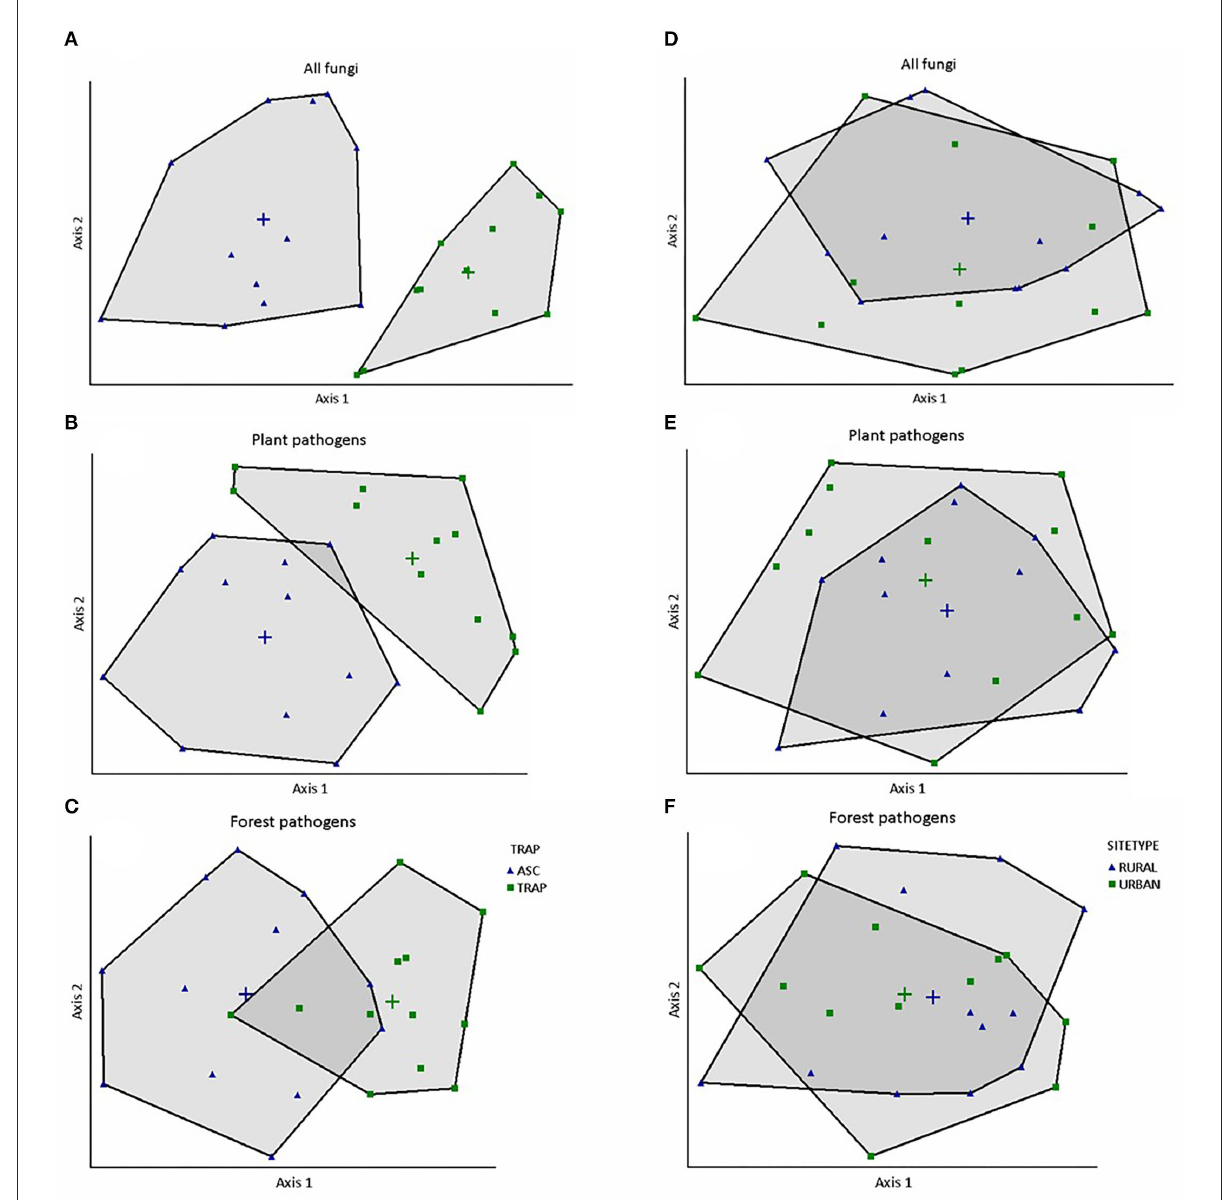
FIGURE3 Nonmetric multidimensional scaling ordination shows that the relative abundance of fungal species collected in aerial spore collectors (ASC) differed (i.e., little or no overlap) from those collected in Lindgren funnel traps (TRAPS) for (A) all fungi (809 OTUs), (B) plant pathogens (157 OTUs), and (C) forest pathogens (70 OTUs). Conversely, fungal species composition in urban vs. rural sites was quite similar for (D) all fungi, (E) plant pathogens, and (F) forest pathogens. Each point in each graph represents 1 of 24 total